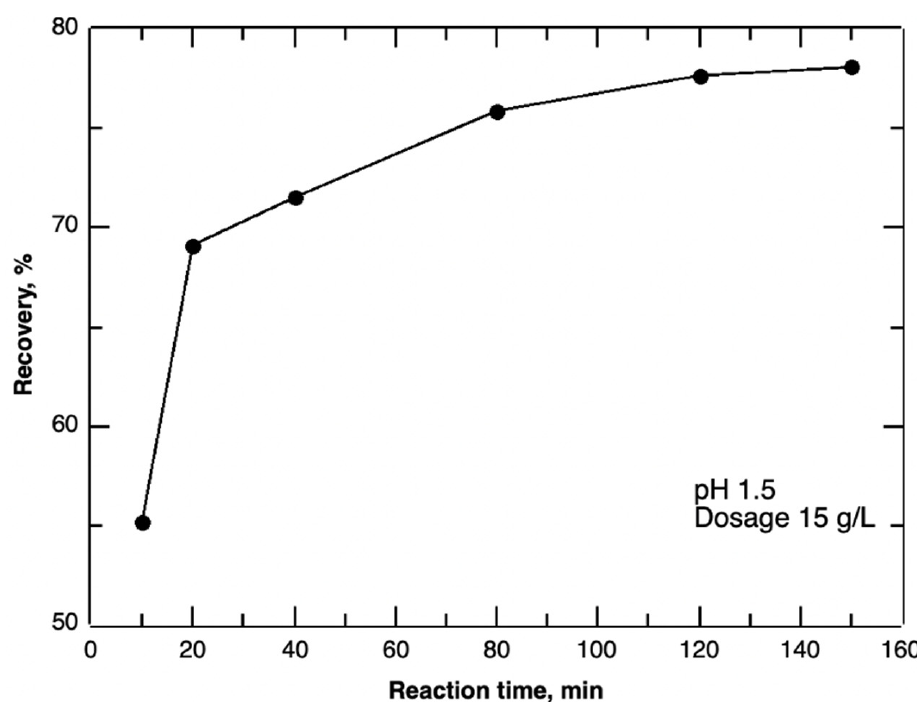
Figure 3. Effect of oxalic acid precipitation reaction time on REEs recovery at a fixed pH of 1.5 and dosage of 15 g/L.